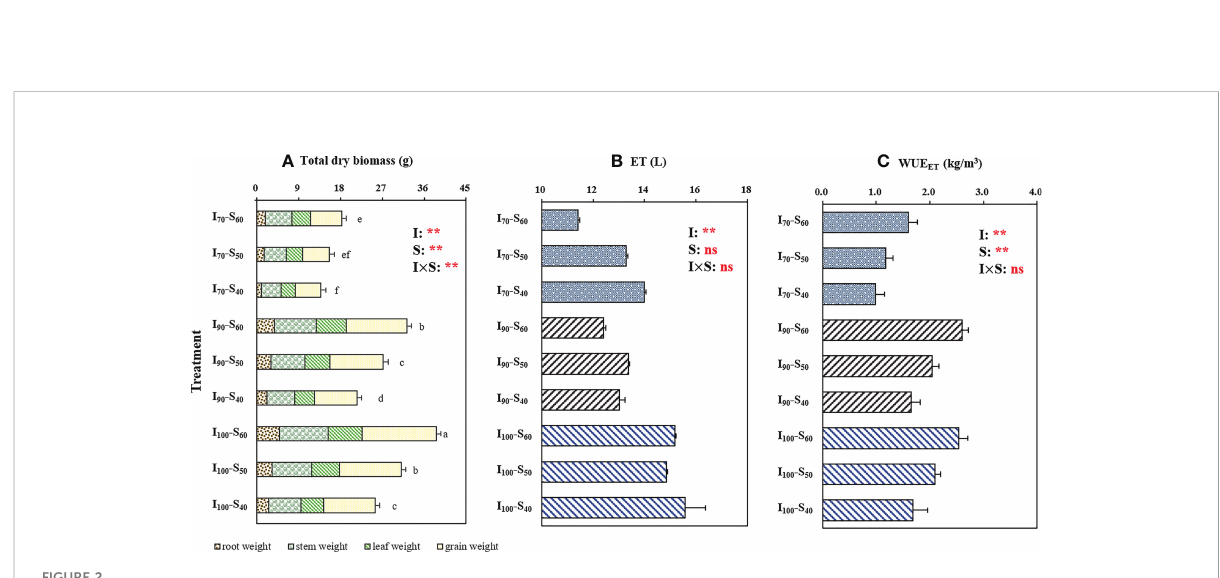
FIGURE 2 The effect of treatment and output of two-way analysis of variance (ANOVA) for (A) dry biomass of grain, stem, leaf, and root, (B) evapotranspiration (ET), and (C) WUE ET of rice as in fl uenced by different water regimes and soil clay contents (mean ± SD; n = 4). I 70 , I 90 and I 100 represent irrigation regimes of fl ooding with 30mm (upper limit) when the soil water reaches 70% of saturation (lower limit); fl ooding with 30mm (upper limit) as the soil water reaches 90% of saturation (lower limit); and fl ooding with 30mm (upper limit) as the soil water reaches 100% of saturation (lower limit). S 40 , S 50 , and S 60 indicate soil clay content with 40%, 50% and 60% respectively. Different letters mean signi fi cant differences ( p <0.05). I, S, and I×S indicate irrigation regime, soil type, and the interaction between irrigation regime (I) and soil type (S), respectively. ns and ** represent no signi fi cance and p <0.01,